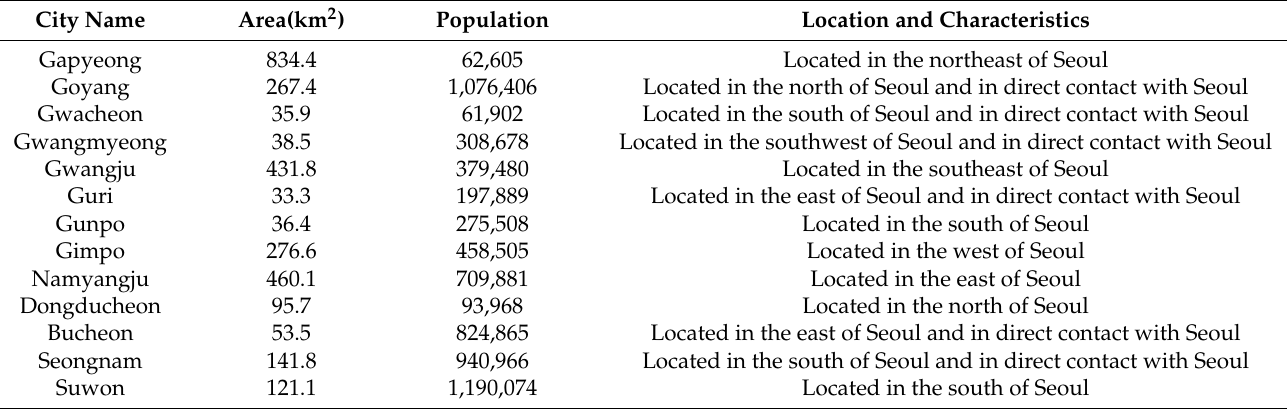
Table A1. Current status of 31